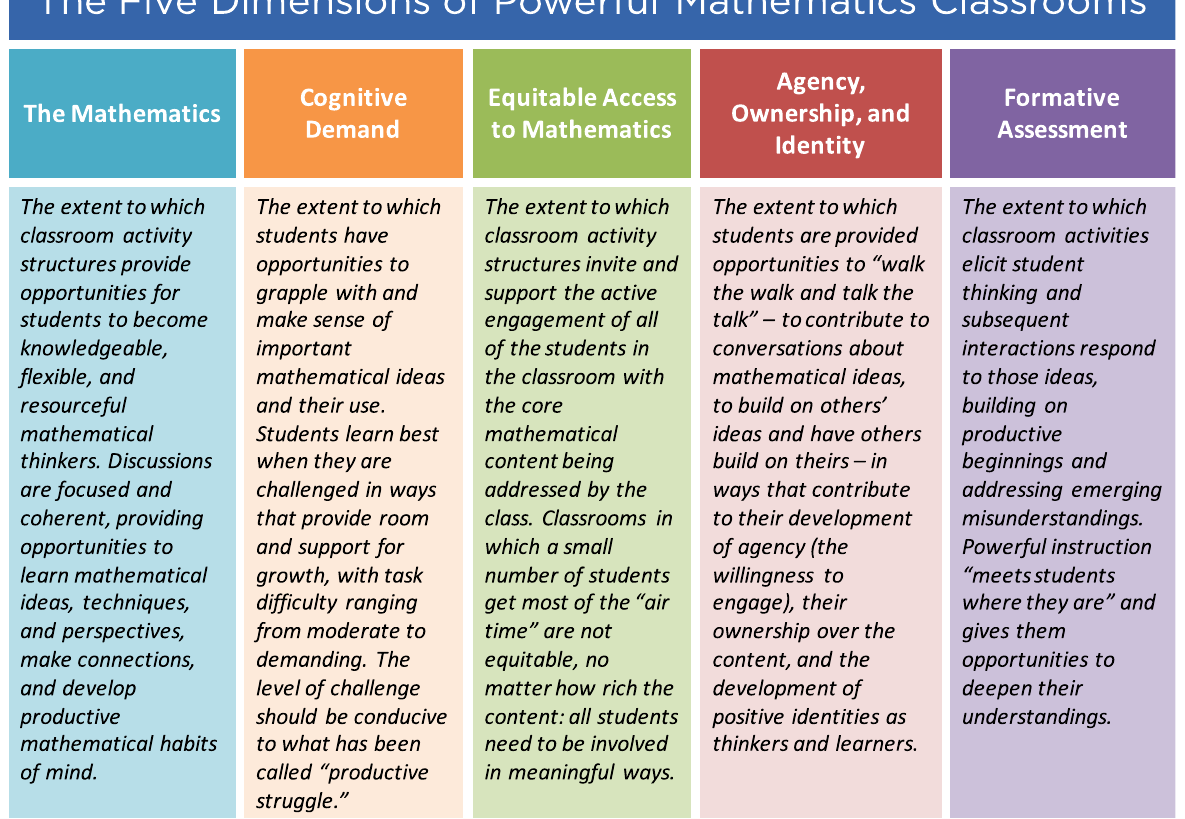
Fig. 1 The TRU Mathematics Framework: The five dimensions of powerful mathematics